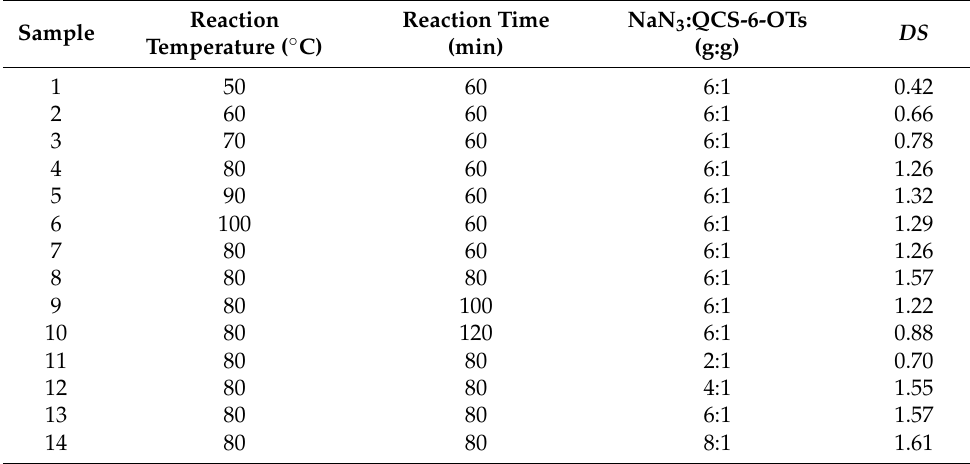
Table 2. DS of QCS-N 3 obtained under different reaction conditions. Sample